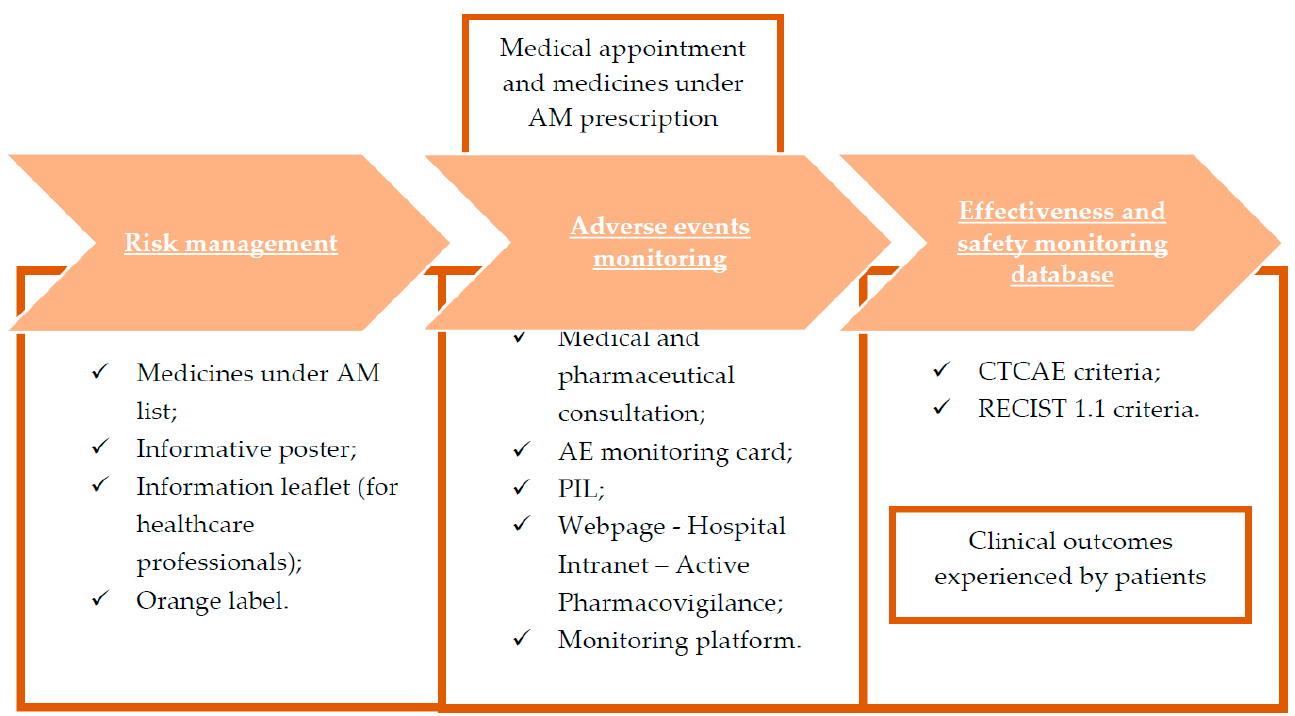
Figure 1. Methodology representation. AE, adverse events; AM, additional monitoring; CTCAE, Common Terminology Criteria for Adverse Events; PIL, patient information leaflet; RECIST, Response Evaluation Criteria in Solid Tumors.